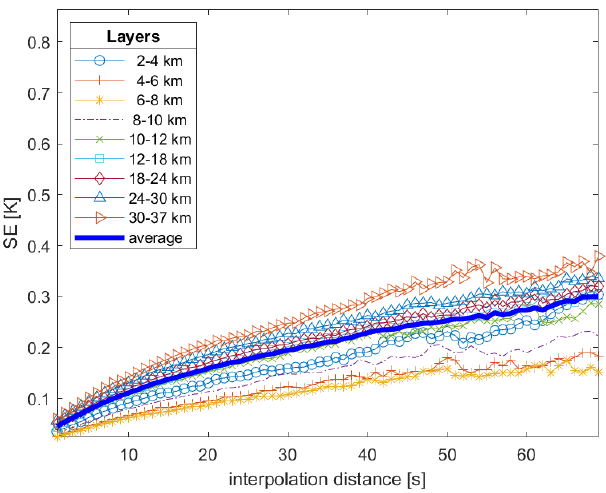
Figure 11. Each line shows the linear interpolation SE as a func- tion of the interpolation distance (s) for a specific atmospheric layer in the range of 2–37km. The depicted SE is the quadratic average of Eq. (8) for each altitude and interpolation distance in the vali- dation data set. The interpolation distance ( x axis) is given by the geometric mean of the distances of all missing data from the clos- est good data, y − and y + . The graph is obtained my merging the block-bootstrap simulations with average gap sizes µ G = 10 and